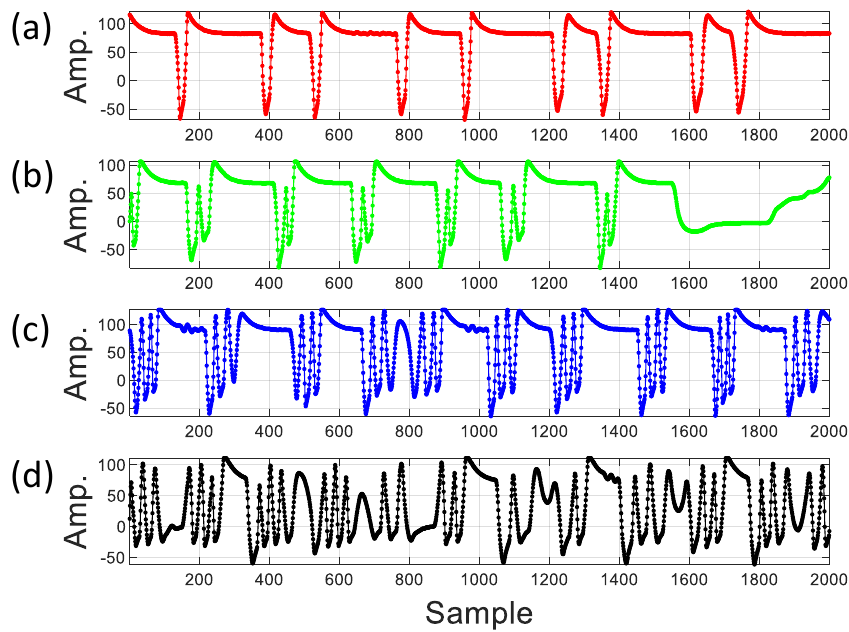
Figure 6. Received signal captured on VLC photodiode corresponding to (from top): ( a ) 1 finger; ( b ) 2 fingers; ( c ) 3 fingers; and ( d ) 4 fingers